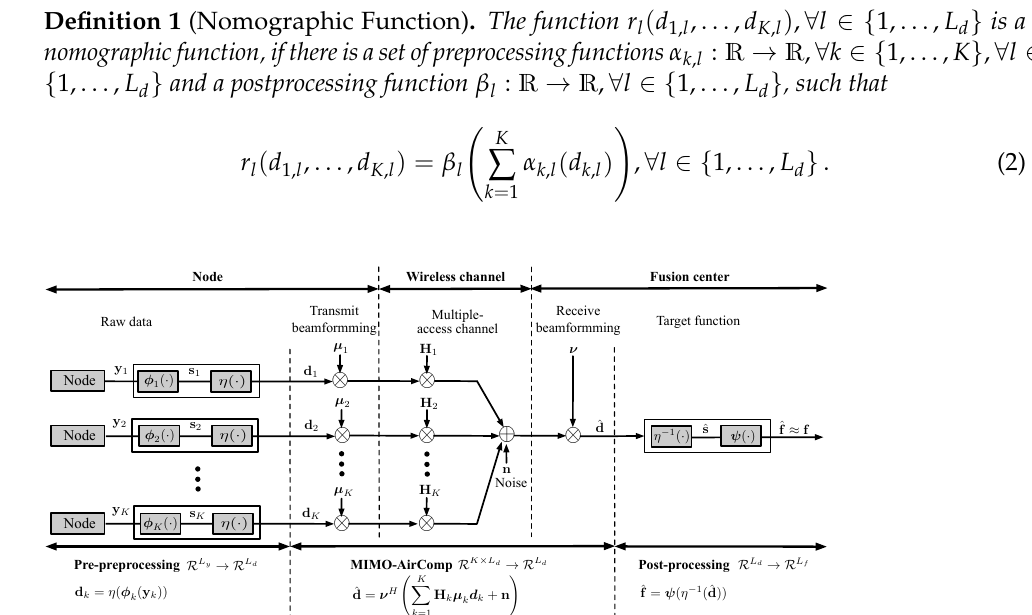
Figure 1. System diagram of the proposed MIMO-AirComp framework consisting of the local preprocessing of nodes, the aggregation of the wireless channel, and the postprocessing at the